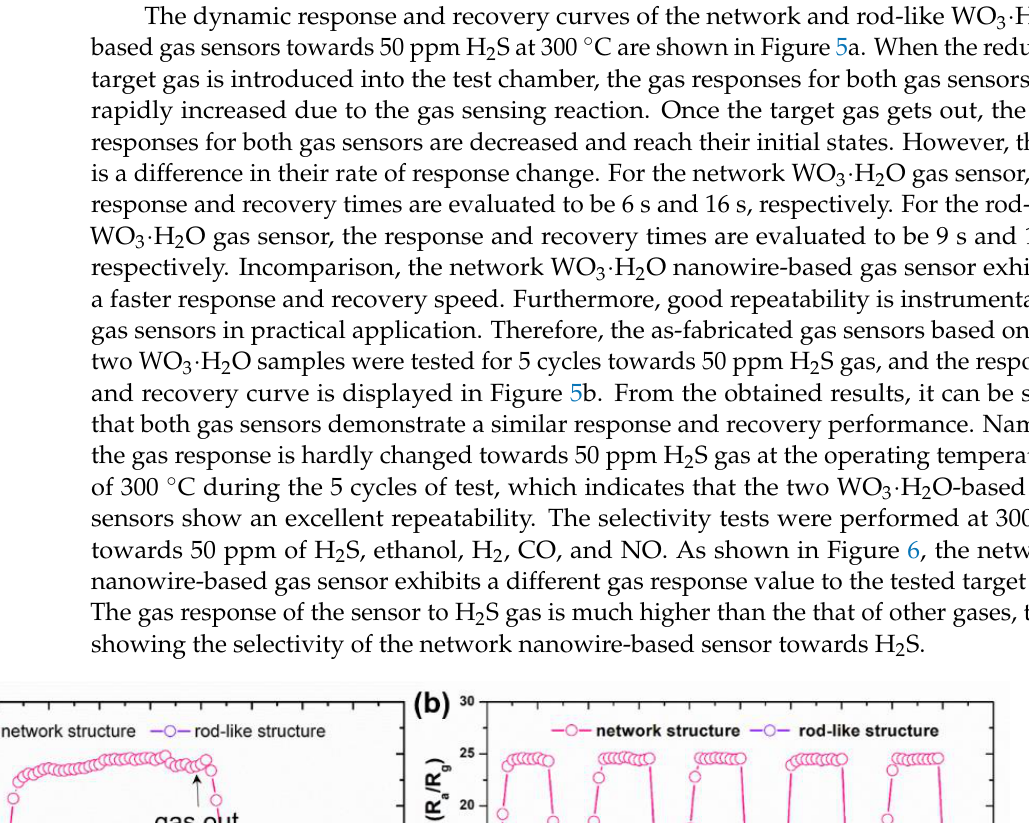
Figure 6. Selectivity of the network nanowire-based gas sensor to different gas at 50 ppm. 3.3. Gas Sensing Mechanism It is well known that the gas sensing mechanism of metal oxide semiconductor-based gas sensors can be elucidated inthe following way: the surface sensing reaction is caused by the resistance change owing to the adsorption and desorption of test gas molecules on the sensitive material surface, which is the main reason for thesensor response change [20,21]. As a result, explaining the gas sensing mechanism for WO 3 ·H 2 O-based gas sensors is necessary. For WO 3 , ·H 2 O as the typical n-type metal oxide semiconductor, the WO 3 ·H 2 O-based gas sensor is first exposed in air and oxygen molecules closed to the sens- ing material will be easily adsorbed on the surface of the n-type WO 3 ·H 2 O material byway of physical adsorption or chemical adsorption. Owing to their high electron affinity of 0.43 eV, the adsorbed oxygen molecules will capture free electrons, which come from conduc- tion bands of sensitive material, resulting in the formation of various adsorbed oxygen ions on the sensor surface, such as O 2 − , O − and O 2 − . Thereafter, the consumption of free electrons leads to the formation of a electron depletion layer on the sensitive material sur- face, reducing the conductive channels of the sensitive WO 3 ·H 2 O material. Hence, the re-